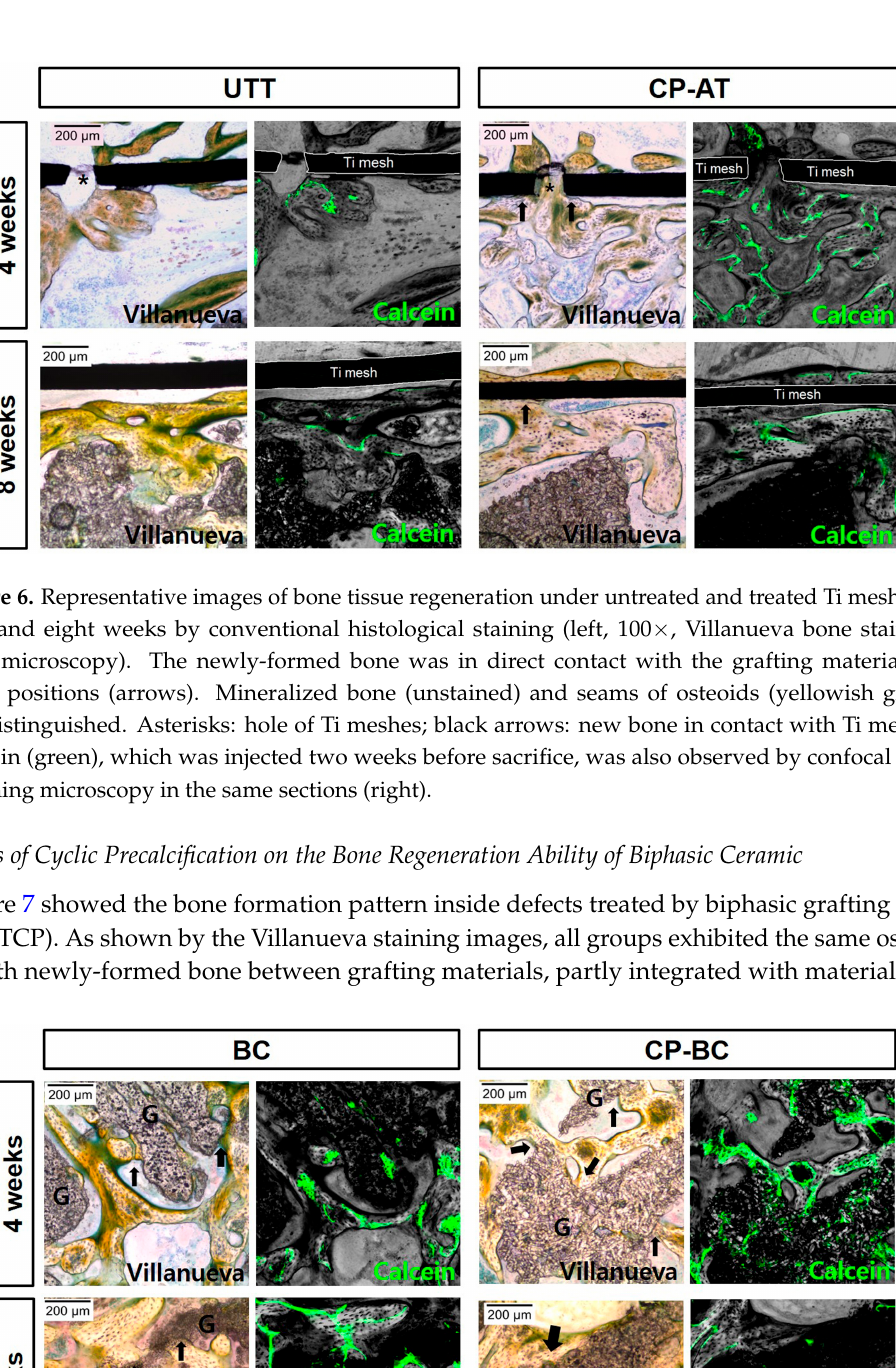
Figure 8. Percentage of mineralized area labeled by calcein green in relation to the determined area at different periods in defects exposed to untreated (BC) or treated (CP-BC) biphasic grafting materials. * Significantly different between groups ( p < 0.05).